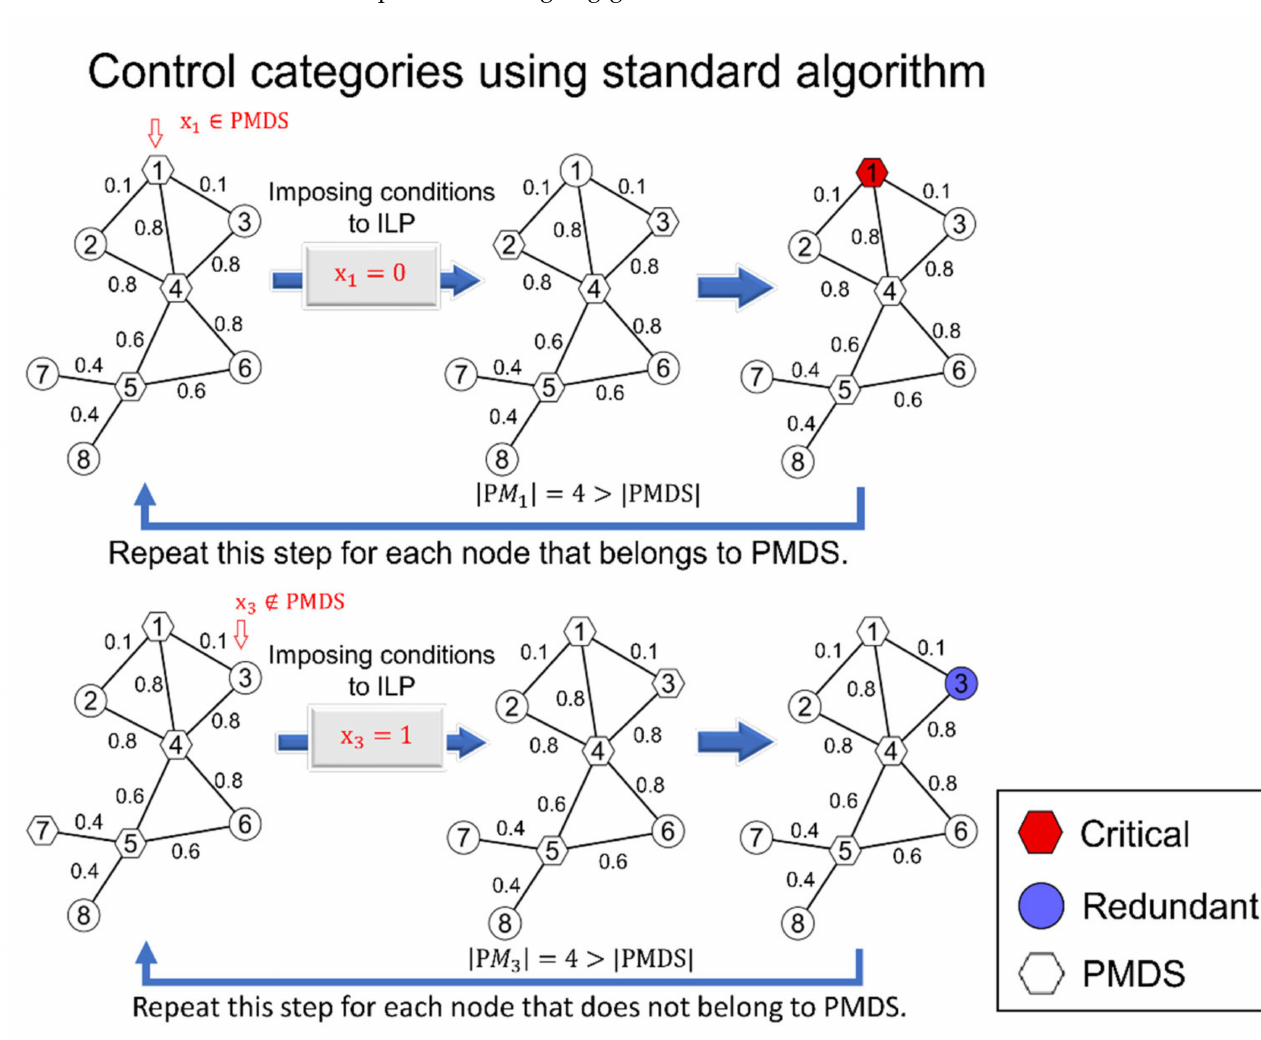
Figure 2. Illustration of the standard algorithm for determining control categories after preprocessing steps were performed on a probabilistic network. Note that each edge has a failure probability score. The preprocessing steps consisted of three mathematical propositions. See the Methods section for the complete proposed CPMDS